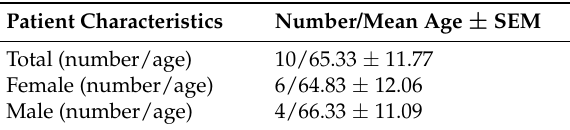
Table 1. Characteristics of patients in